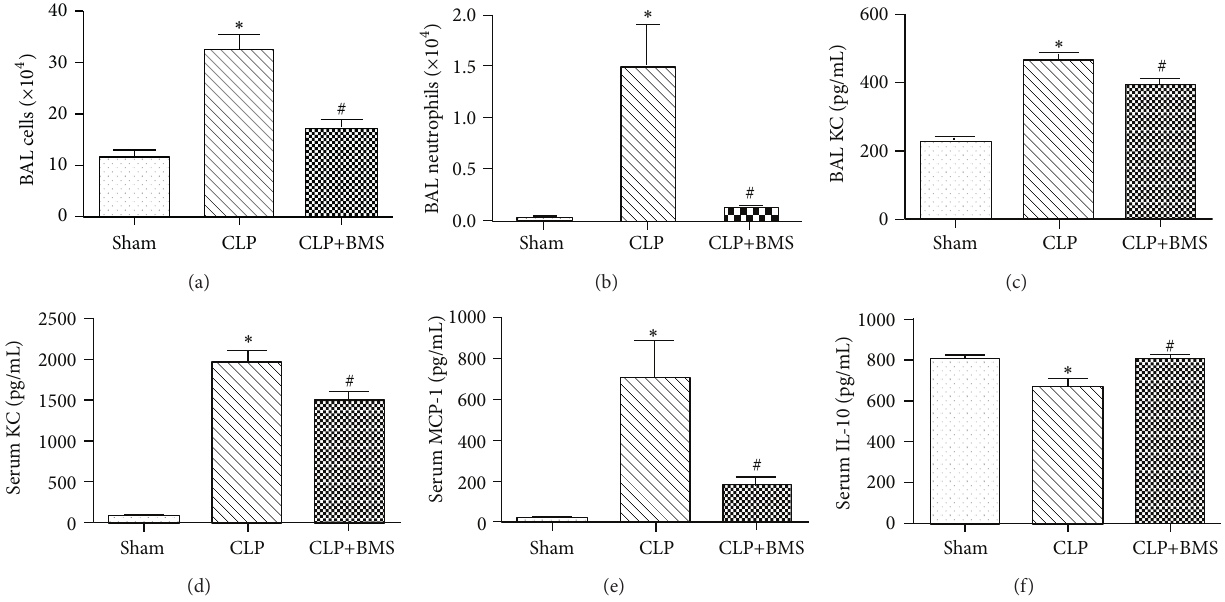
Figure 3: NF- 𝜅 B inhibition reduces lung inflammation after CLP. (a) Total cells, (b) neutrophils, and (c) KC levels in BAL at 24 hours after surgery in control mice treated with sham laparotomy (Ctrl), mice that underwent CLP followed by vehicle (CLP), and mice treated with CLP followed by BMS-345541 (CLP+BMS). 𝑁 = 10 per group. ∗ 𝑃 < 0.05 for CLP versus sham laparotomy controls (Ctrl); # 𝑃 < 0.05 for CLP+BMS versus CLP. (d) Serum cytokine levels for KC, MCP-1, and IL-10 at 24 hours after surgery. 𝑁 = 5 per group. ∗ 𝑃 < 0.05 for CLP versus Ctrl; # 𝑃 < 0.05 for CLP+BMS versus CLP. Results are presented as mean ± SE.